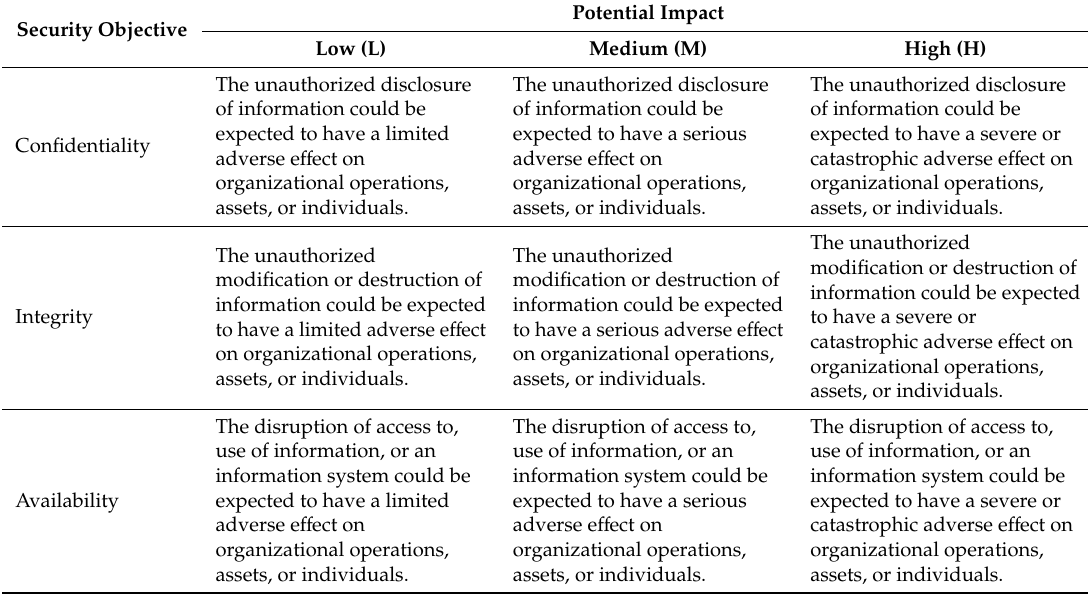
Table 1. The potential impact criteria for security objectives